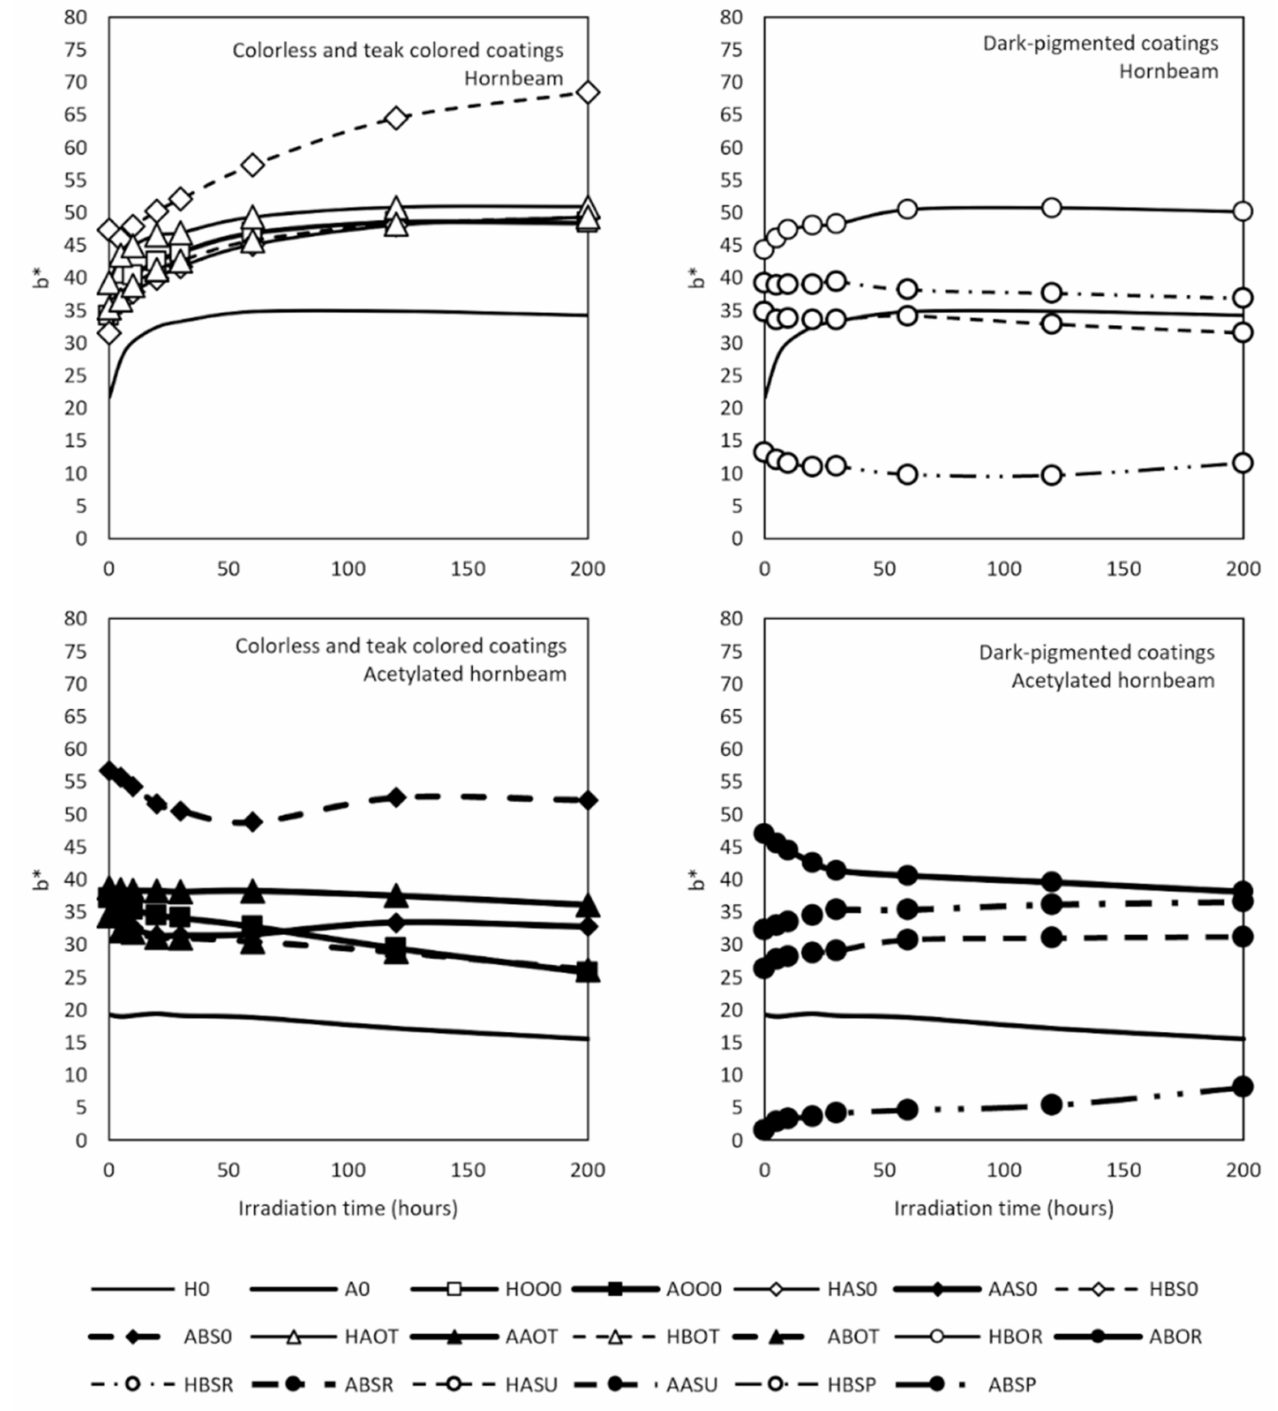
Figure 5. Change of yellow hue (b*) during 200 h of xenon lamp irradiation. Artificial aging only incurs UV light degradation and eliminates the impact of other weather elements and microorganisms. Consequently, the color coordinates mostly increase. Xenon light can simulate the effect of sunlight during weathering, but only at long exposure times, as the yellowing will be about three times more intensive in the short term